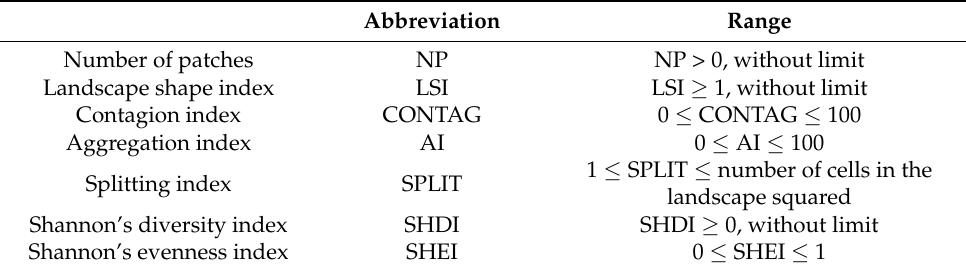
Table 4. Landscape metrics at landscape level for pattern change